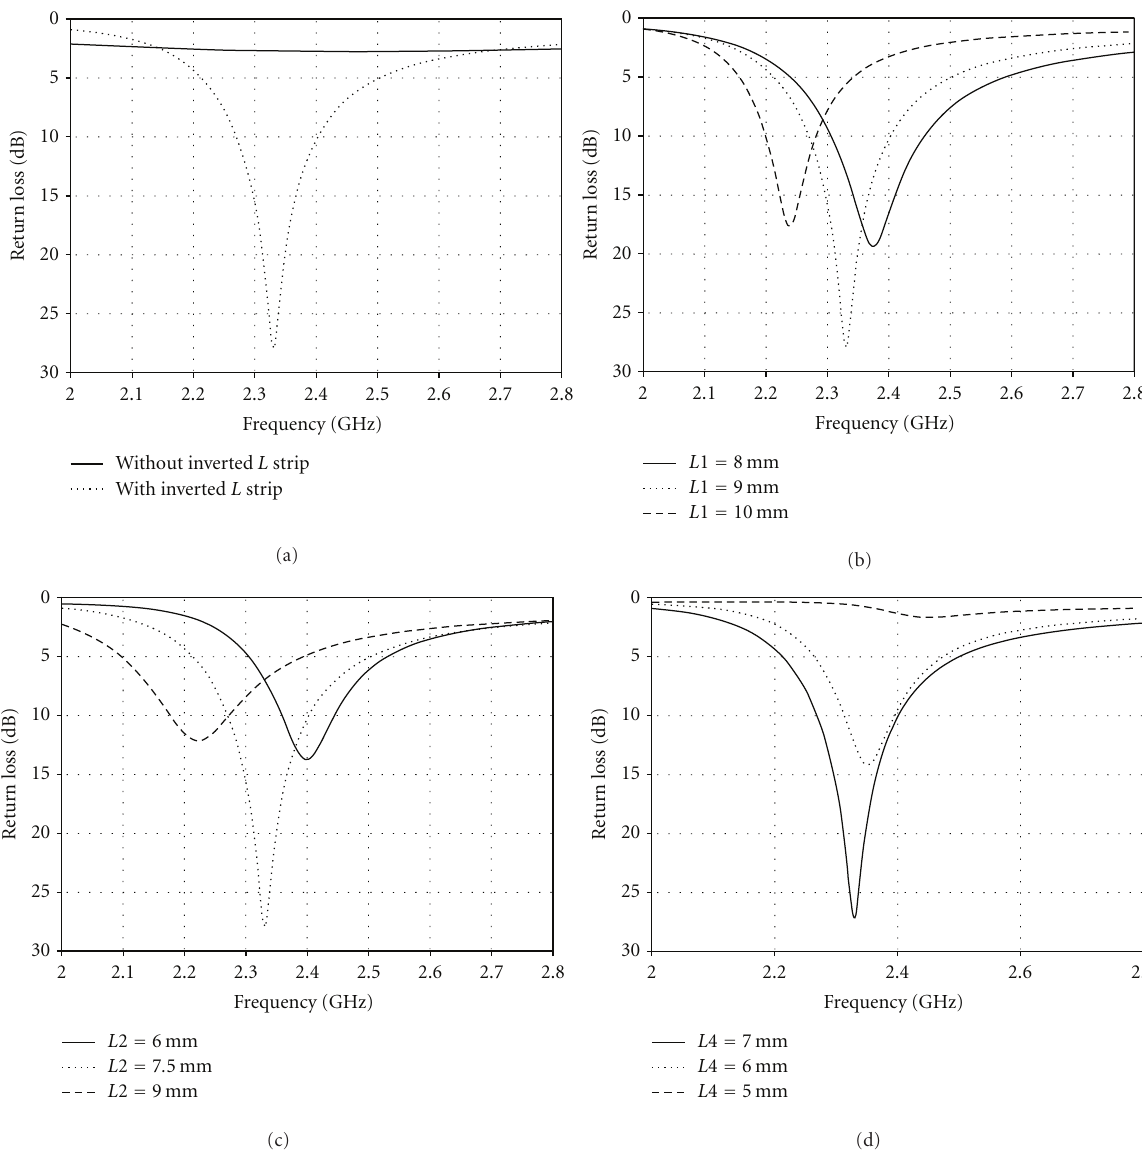
Figure 2: Simulated return loss characteristics: (a) with and without inverted L strip, (b) variation in L 1, (c) variation in L 2, (d) variation in L